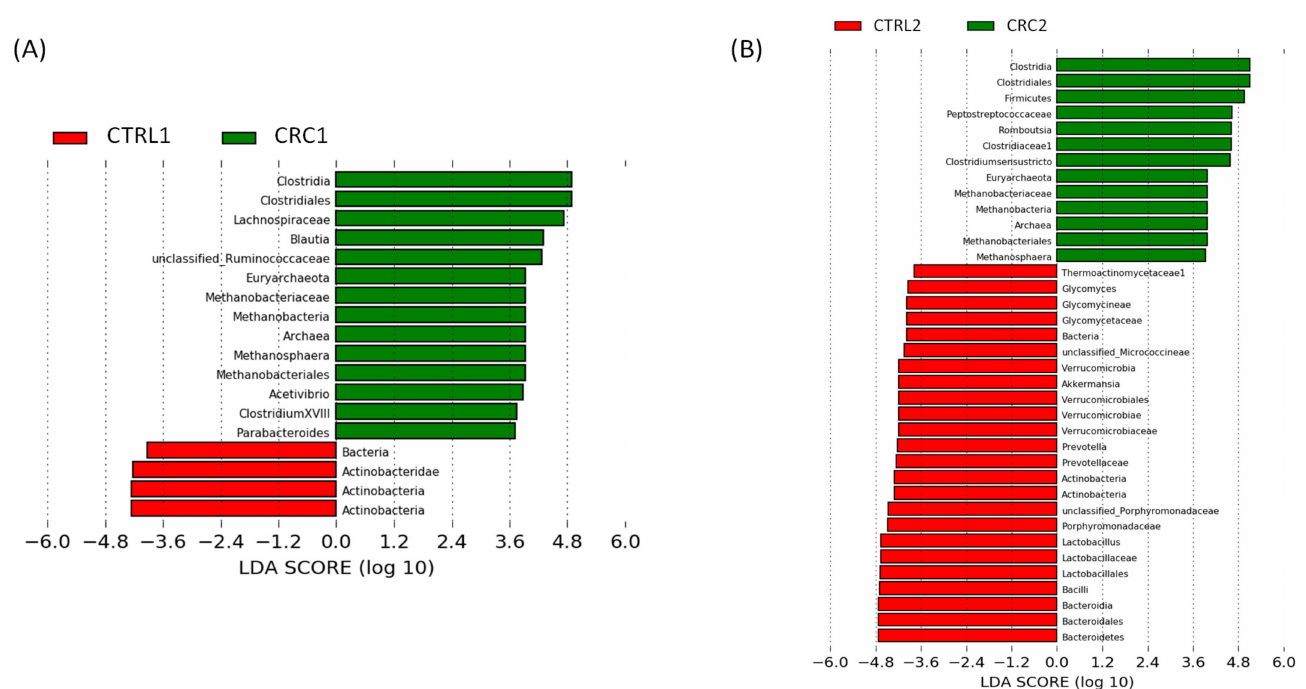
Figure 6. Linear discriminant analysis (LDA) effect size (LEfSe) of gut microbiota showing significant differences in the fecal microbiota of control (CTRL) and DHMH-induced colorectal cancer (CRC) rats. ( A ) Rats at 20 weeks of age and ( B ) rats at 26 weeks of age. Red bars, CTRL groups; Green bars, CRC